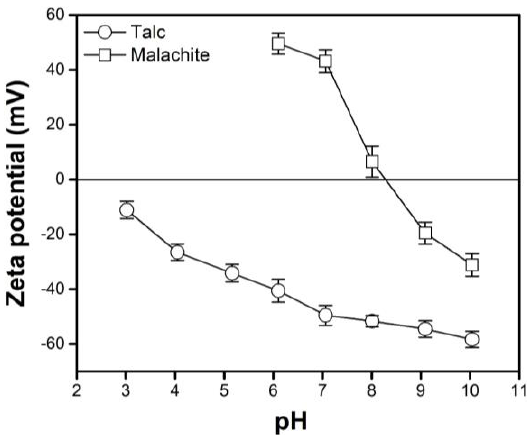
Figure 6. Zeta potential of malachite and talc as a function of the solution pHs.